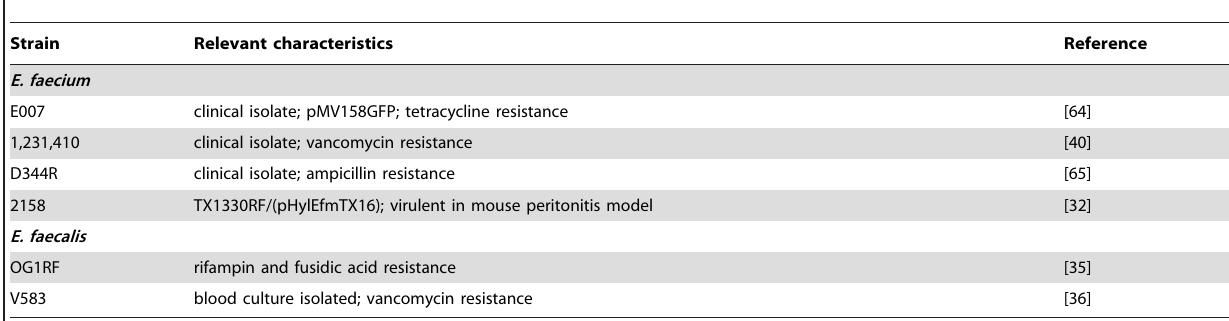
Table 1. Bacterial strains used in this